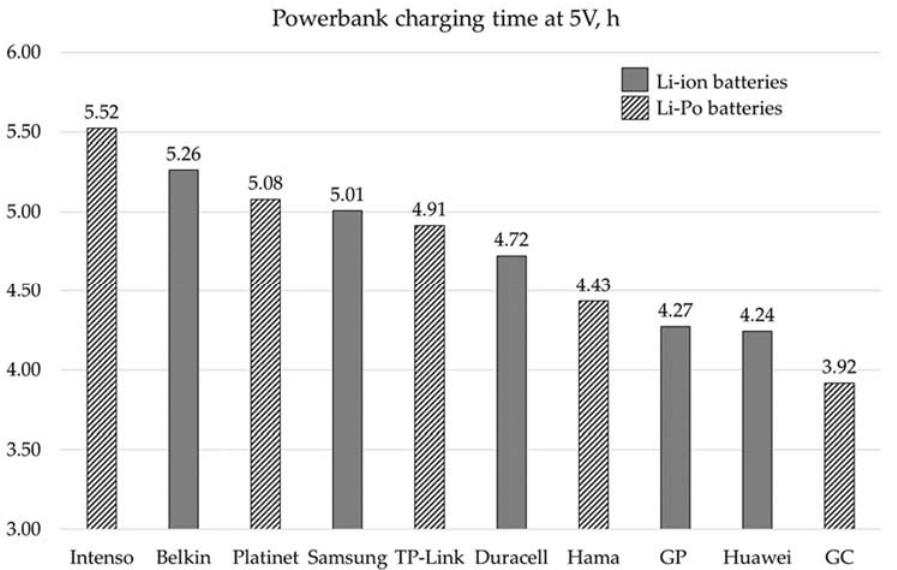
Table 4. Comparison of the number of possible discharging and charging modes of power banks (‘6.’ only standard mode Figure 8. Charging time (in hours) of power banks at U = 5 V voltage. Figure 8. Charging time (in hours) of power banks at U = 5 V voltage. at 5 V, ‘+’ possible quick modes at 9 V or 12 V). Other determinants that the respondents follow when buying a power bank are the functions of quick charging of target devices from the power bank and the quick charging function of the power bank itself. Among the devices examined, the power banks of four manufacturers had both of these features important for consumers (Table